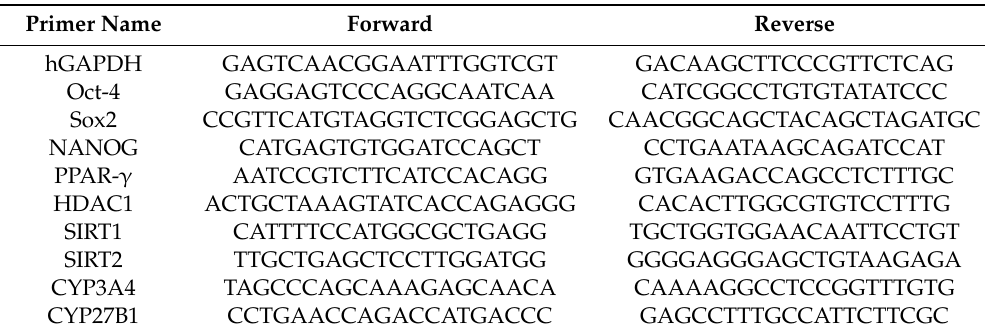
Table 1. Primers sequences.